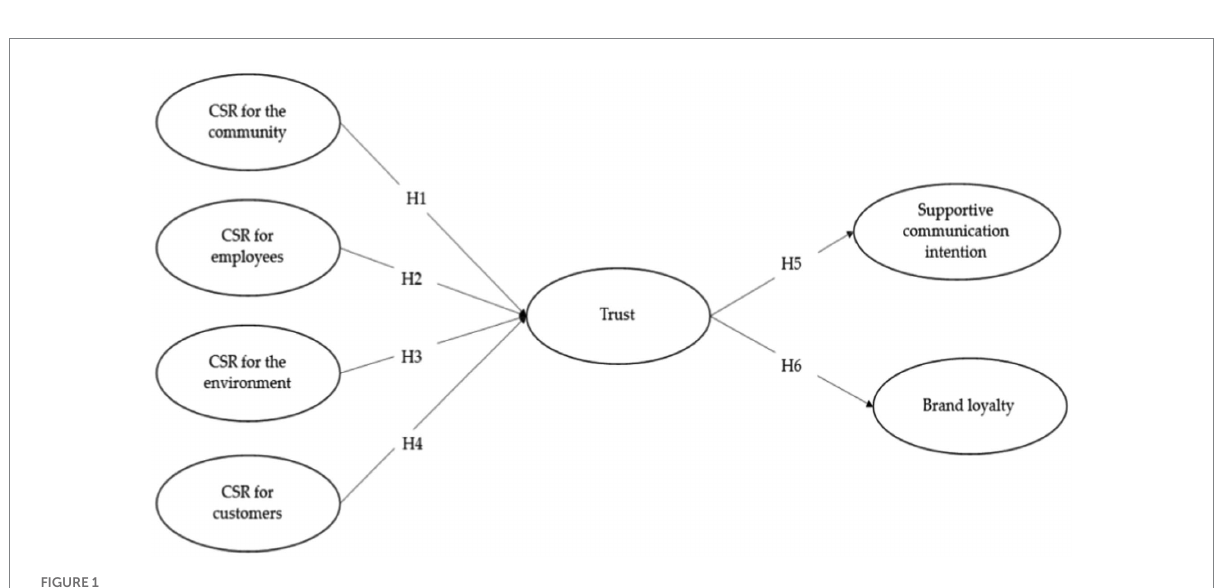
FIGURE 1 Hypotheses of the proposed model.